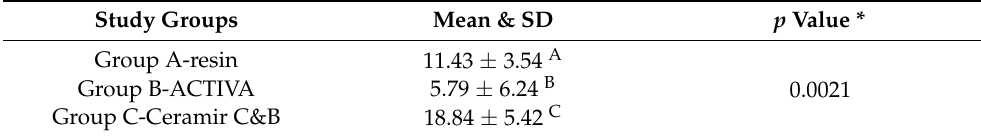
Table 3. Means and SDs for ∆ E values among the study